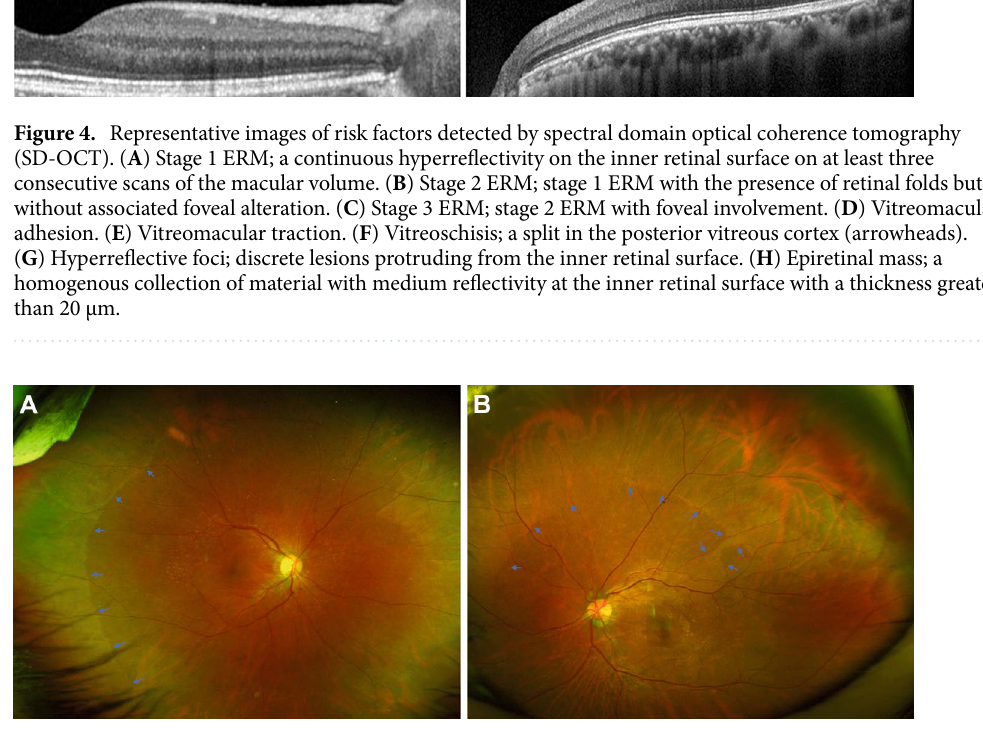
Figure 5. Representative images of eyes with discrete margin of different retinal reflectivity (DMDRR). ( A and B ) discrete margin of different retinal reflectivity in the mid- to far-peripheral retina on ultra-widefield fundus photography